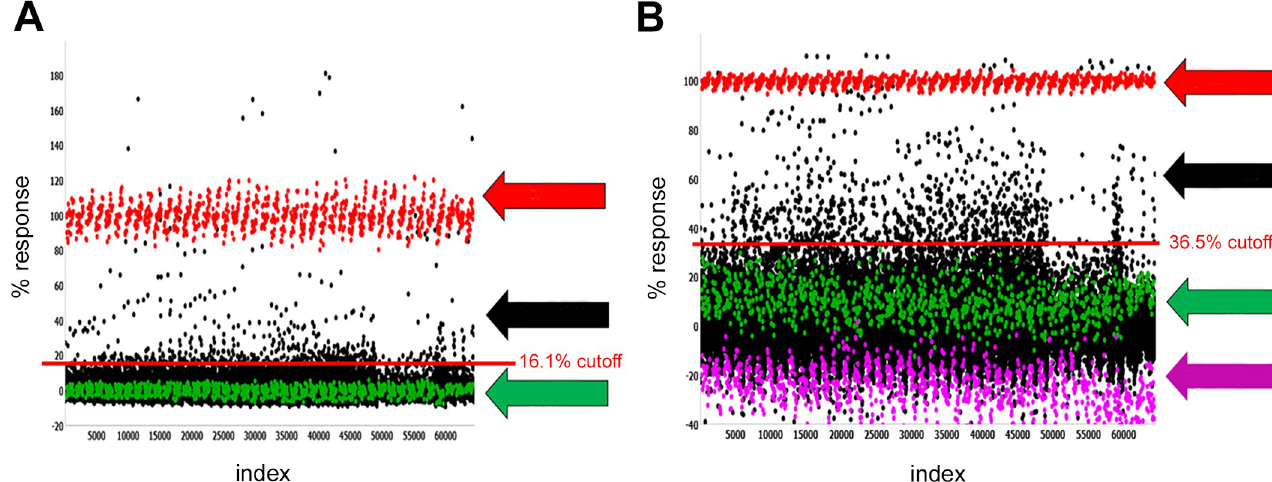
Fig 3. Primary HTS assay data. Scatterplot of all 15,934 compounds tested in ( A ) agonist mode and ( B ) antagonist mode. Each dot graphed represents the activity of a well containing test compound (black, sample field) or controls (red high control; green, low control). Arrows (right) indicated the high control (red), low control (green) and the sample field (black, datapoints between the calculated cutoffs (red lines) and high control). For the agonist screen, high control reflected responses to PZQ (10 μ M, red) and the low control represented responses to DMSO (green). For the antagonist screen, the high control reflected responses to DMSO (red) and the low control represented responses to submaximal PZQ (500 nM, green). The response to a maximal PZQ concentration (EC MAX , 10 μ M) is also indicated (magenta). The EC 80 stimulation is qualified as a percentage of the response to the high control PZQ EC 100 (‘EC MAX ’). All plates are assessed for robustness with Z’ > 0.5 and EC Stim between 70–95%.